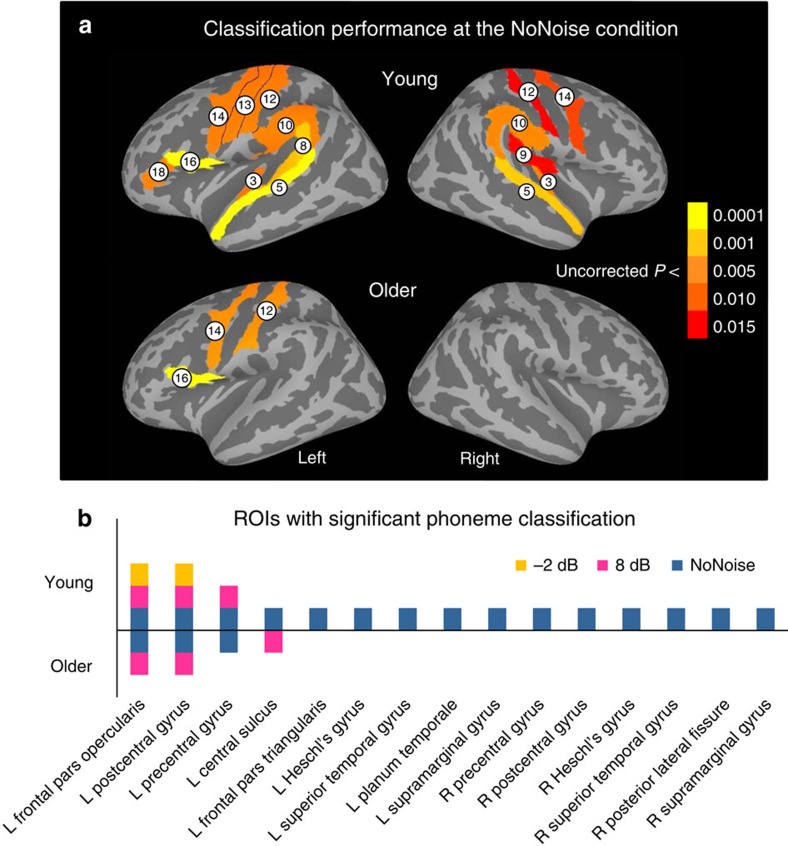
Phoneme classification performance.(a) Regions with significant phoneme classification (AUC>0.5, one-sample t-test with FDR-corrected P<0.05) at the NoNoise condition for each group. (b) Overview of ROIs and SNRs when significant classification was revealed in each group. SNRs at which each ROI showed significant classification are displayed on the y-axis, with ROI labels listed across the x-axis. The top half shows data from young adults and the bottom half shows data from older adults. 3, Heschl's gyrus; 5, superior temporal gyrus; 8, planum temporale; 9, posterior lateral fissure; 10, supramarginal gyrus; 12, postcentral gyrus; 13, central sulcus; 14, precentral gyrus; 16, pars opercularis; 18, pars triangularis.